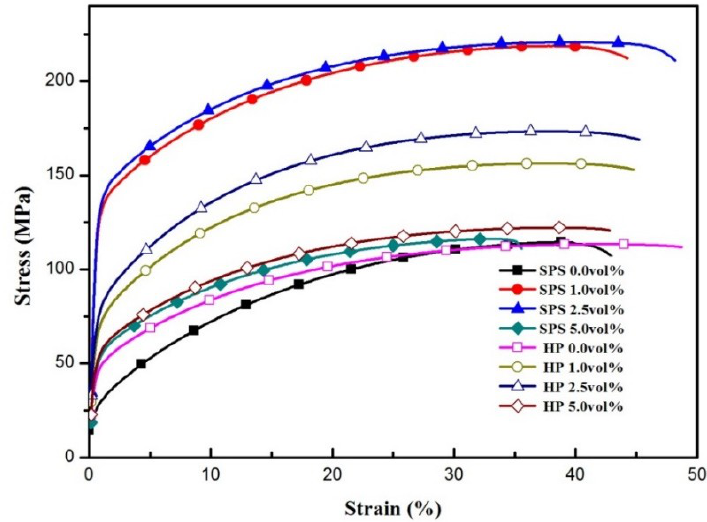
Figure 10. Stress-strain curves of the CNTs@Ag/Ag composites. Table 1. Relative density, electrical conductivity and mechanical properties of the composites with different CNTs contents.